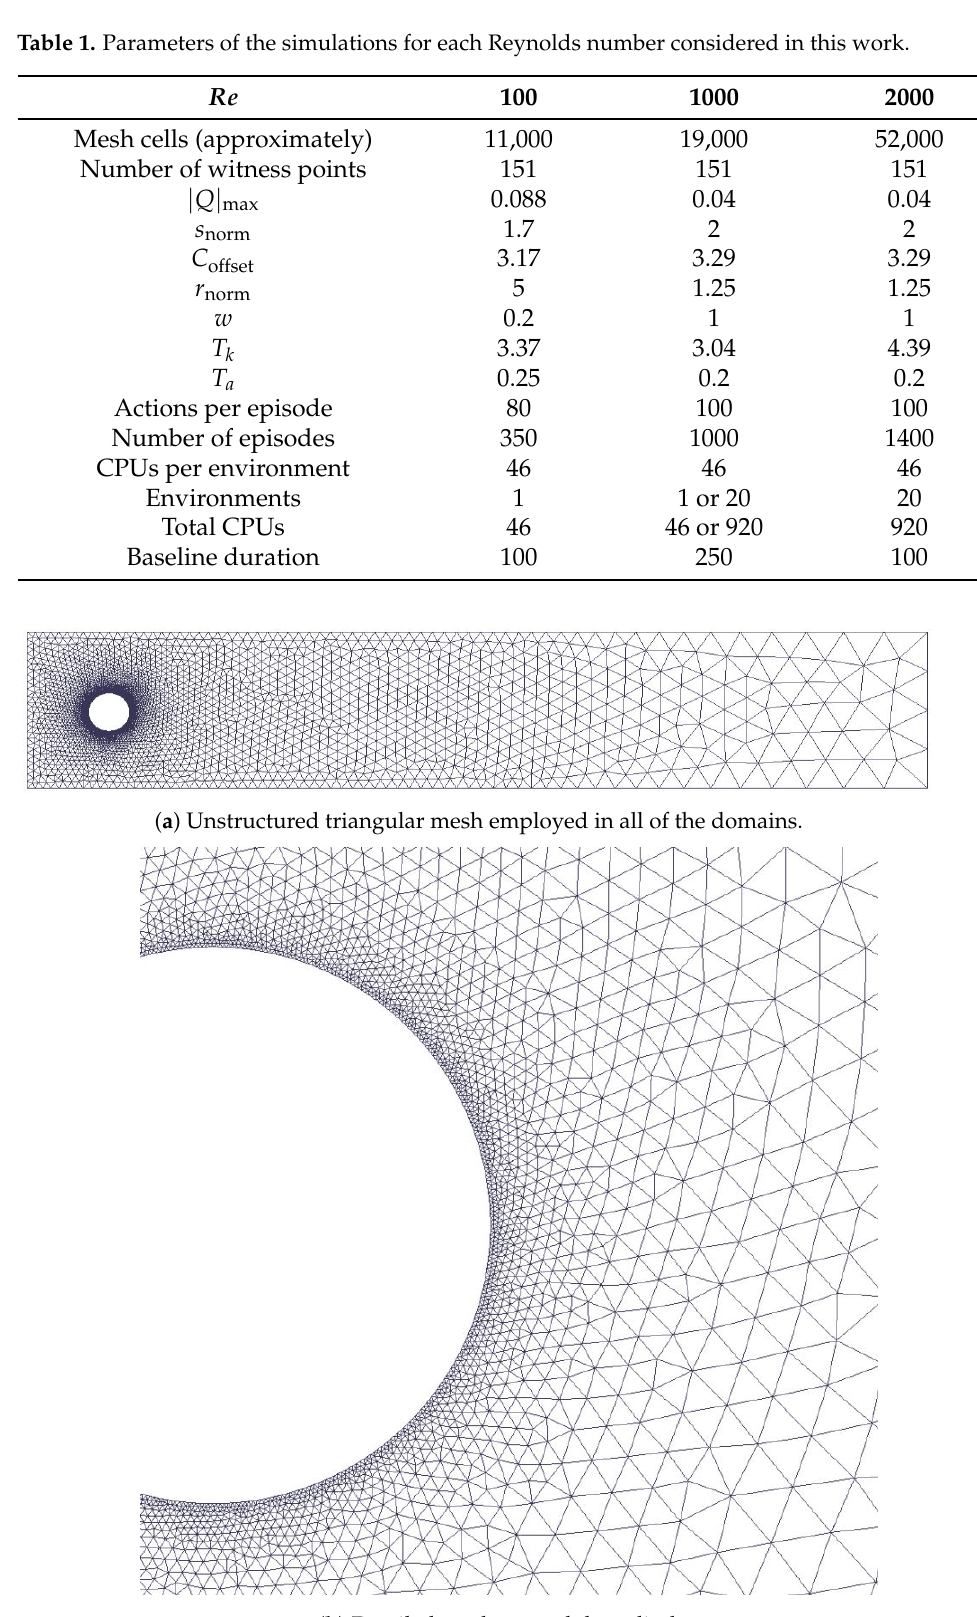
Figure 2. Computational grid used for the Re = 100